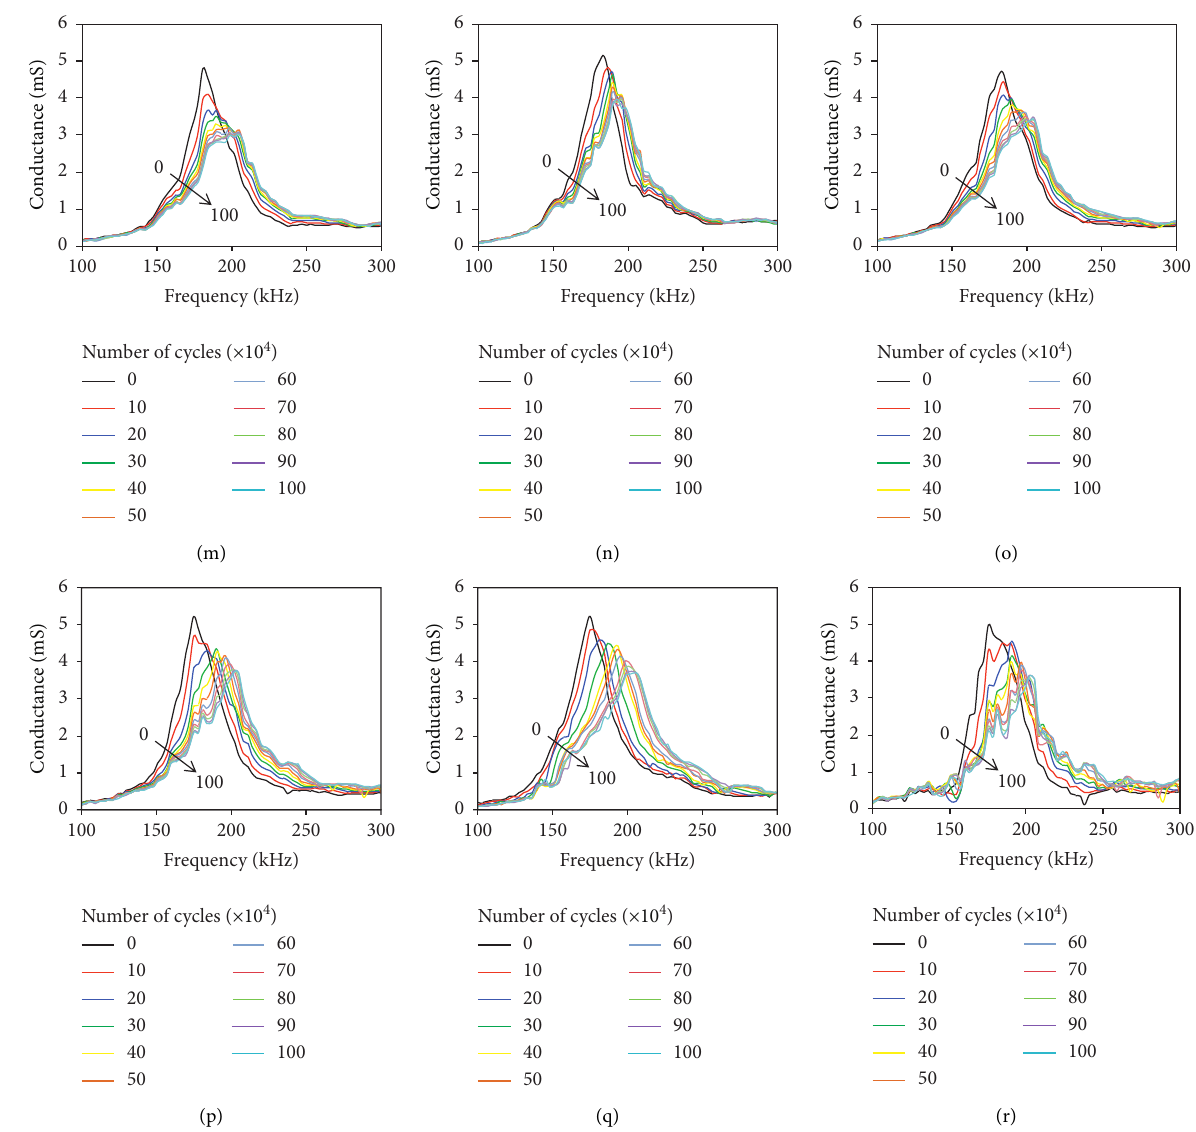
Figure 7: The conductance signatures generated during high cyclic loading for specimens with six different levels of initial damage. (a) I0-1. (b) I0-2. (c) I0-3. (d) I3-1. (e) I3-2. (f) I3-3. (g) I6-1. (h) I6-2. (i) I6-3. (j) I9-1. (k) I9-2. (l) I9-3. (m) I12-1. (n) I12-2. (o) I12-3. (p) I15-1. (q) I15-2. (r)